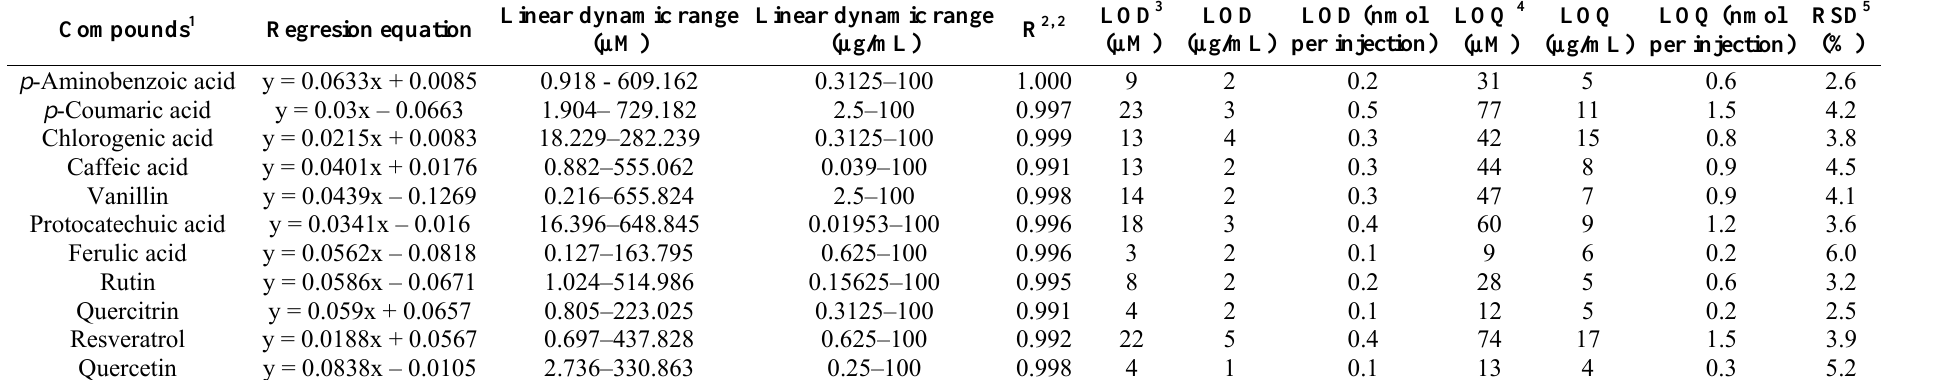
Table 1. Analytical parameters of UV detection.